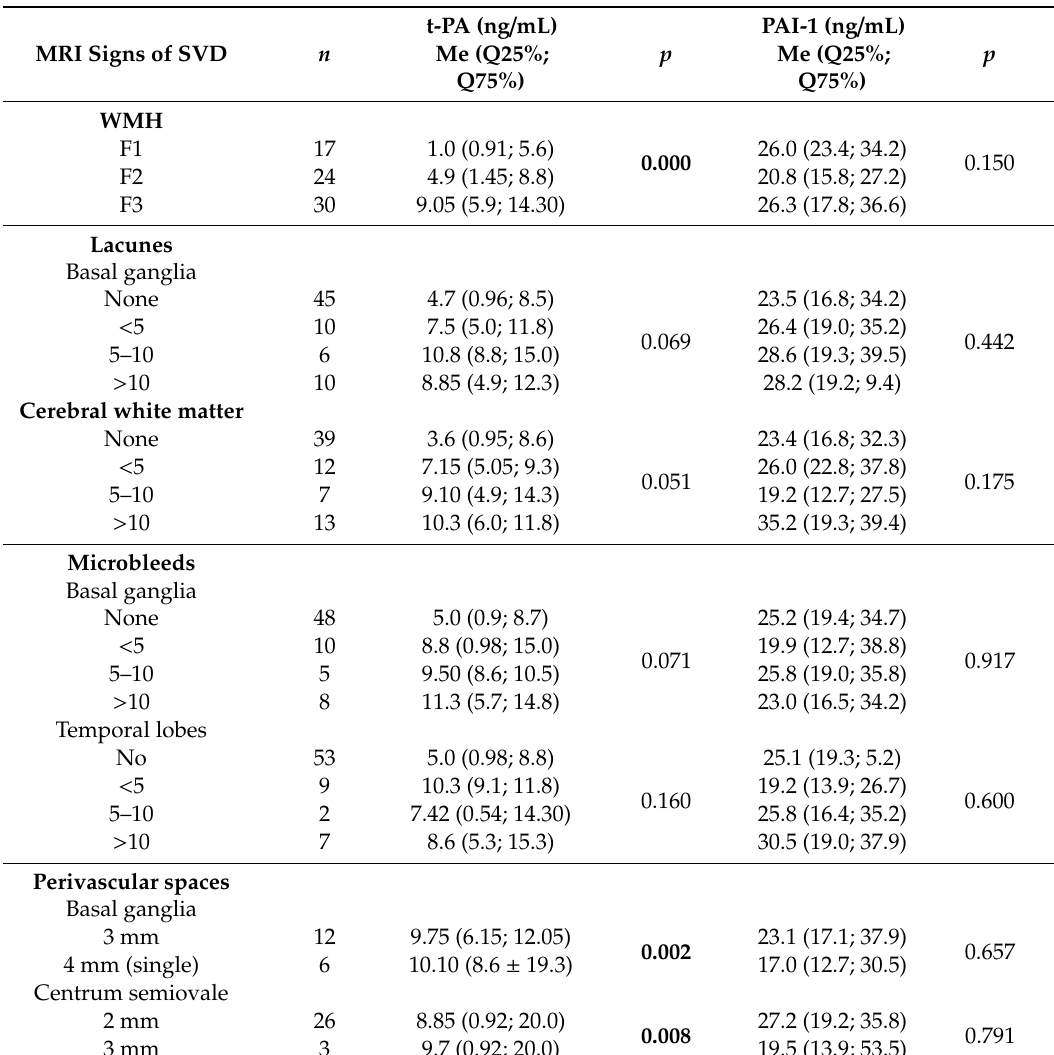
Table 3. Comparative analysis of the levels of tissue plasminogen activator (t-PA) and plasminogen activator inhibitor (PAI-1) with MRI signs of SVD.